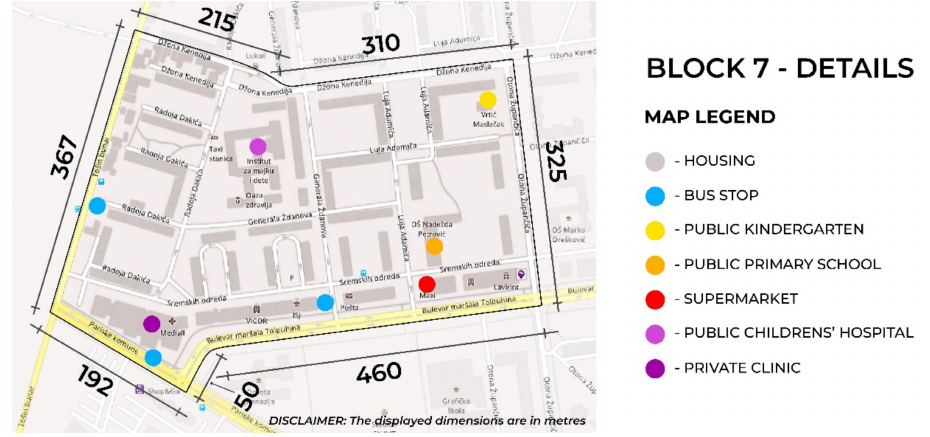
Figure 2. Block 7—Details (Distribution of non-residential urban